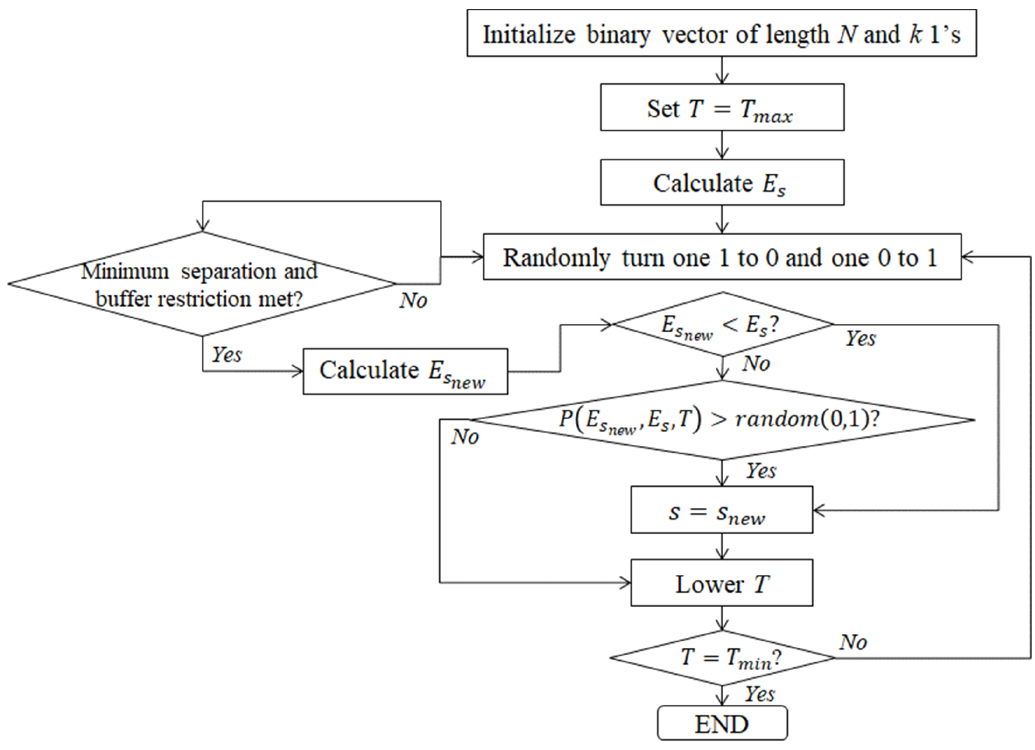
Figure 1. Flowchart for the simulated annealing algorithm used to select the best k wavelength for fish species classification.